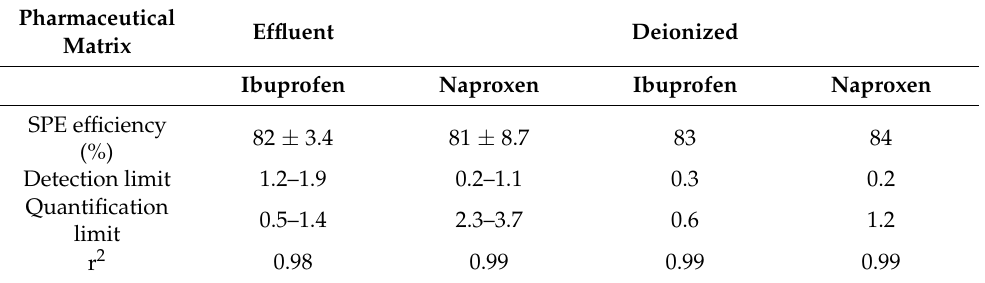
Table 4. Analytical method validation.